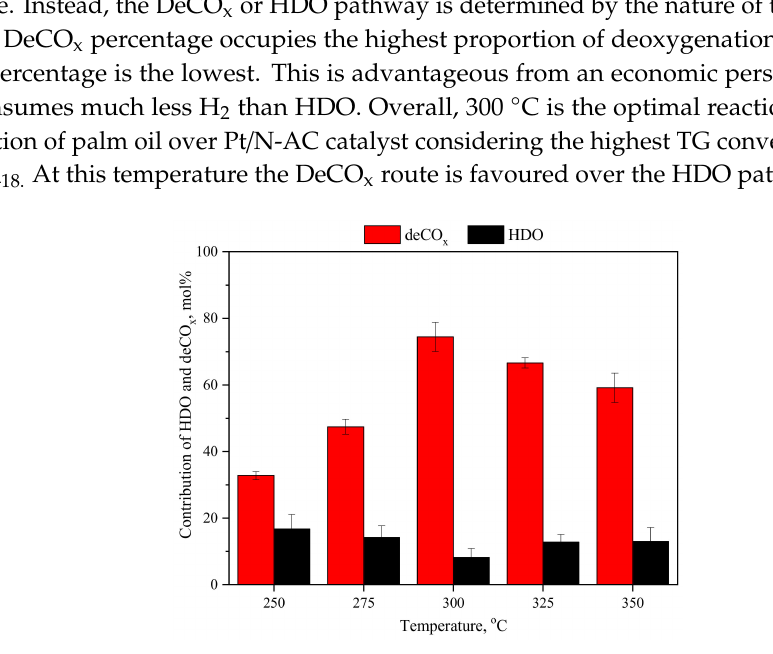
Figure 3. Contribution of HDO and DeCO x under di ff erent reaction